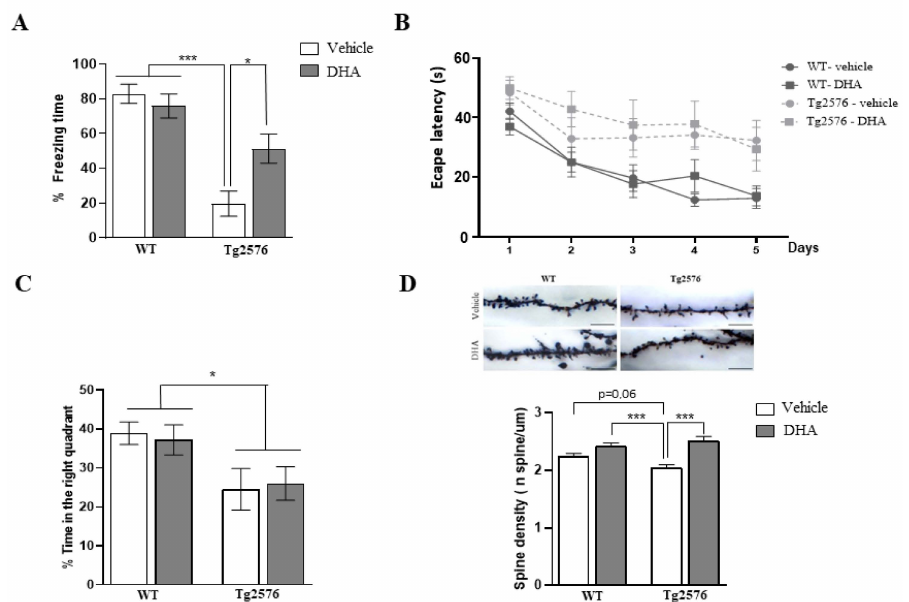
Figure 1. Wild-type (WT) and Tg2576 mice received daily DHA or vehicle and were analyzed 5 weeks later using fear conditioning and the Morris water maze (MWM). ( A ) Freezing behavior from WT and Tg2576 mice treated with DHA or vehicle. Data represent the percentage of freezing time during the test. ( B ) Escape latency of the hidden platform in the MWM test for the WT and Tg2576 mice treated with DHA or vehicle ( C ) Percentage of time spent in correct quadrant during the probe test at day 6. ( D ) Dendritic spine density in CA1 hippocampal neurons from WT and Tg2576 mice treated with DHA or vehicle. In all figures, results are expressed as mean ± SEM (n = 8–11 per group). Two-way analysis of variance (ANOVA) and Tukey’s post hoc test were used for statistical analyses, * p ≤ 0.05, *** p ≤